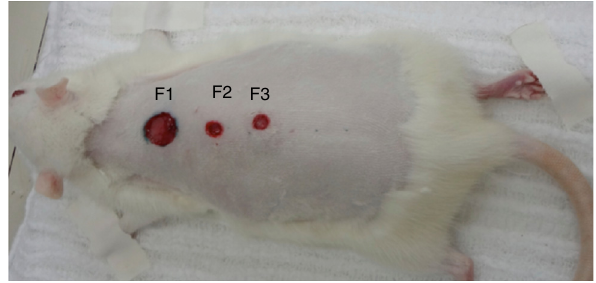
Figure 2 Denomination of the wounds: wound 1 --- control (1.0 cm in diameter); wound 2 --- epithelial (0.6 cm in diameter), and wound 3 --- mixed (0.6 cm in diameter).